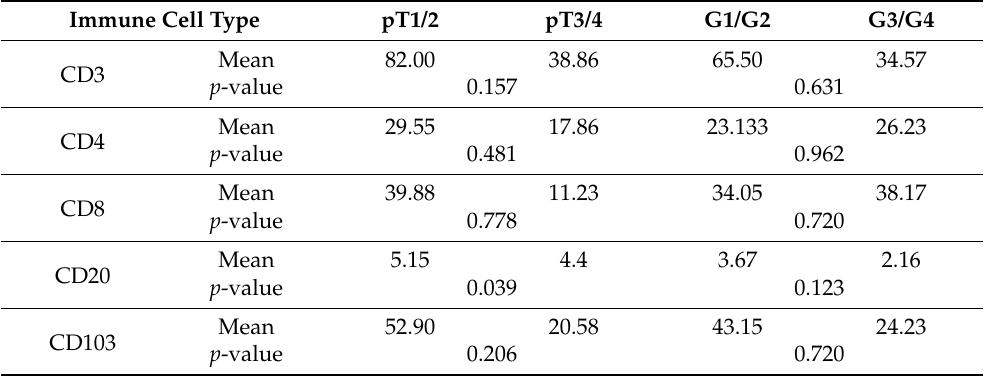
Table 5. Comparison of immune cells infiltrating metastases of ccRCC in relation to clinico- pathological data (Mann–Whitney U test, Bonn cohort, n = 25 patients).